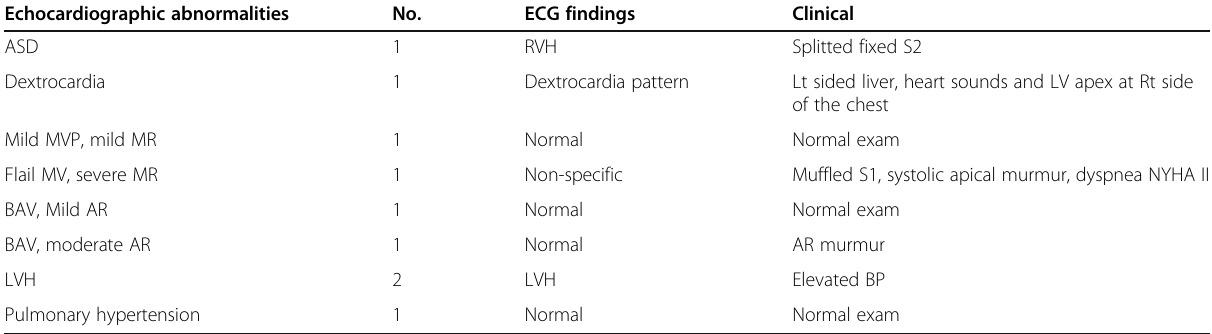
Table 5 Baseline ECG and clinical data of the nine subjects with their abnormal echocardiographic findings Echocardiographic